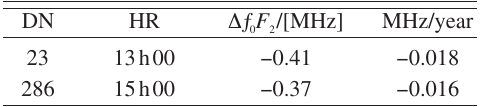
c d Fig. 3a-d. Contour maps of the function (cid:54) ƒ